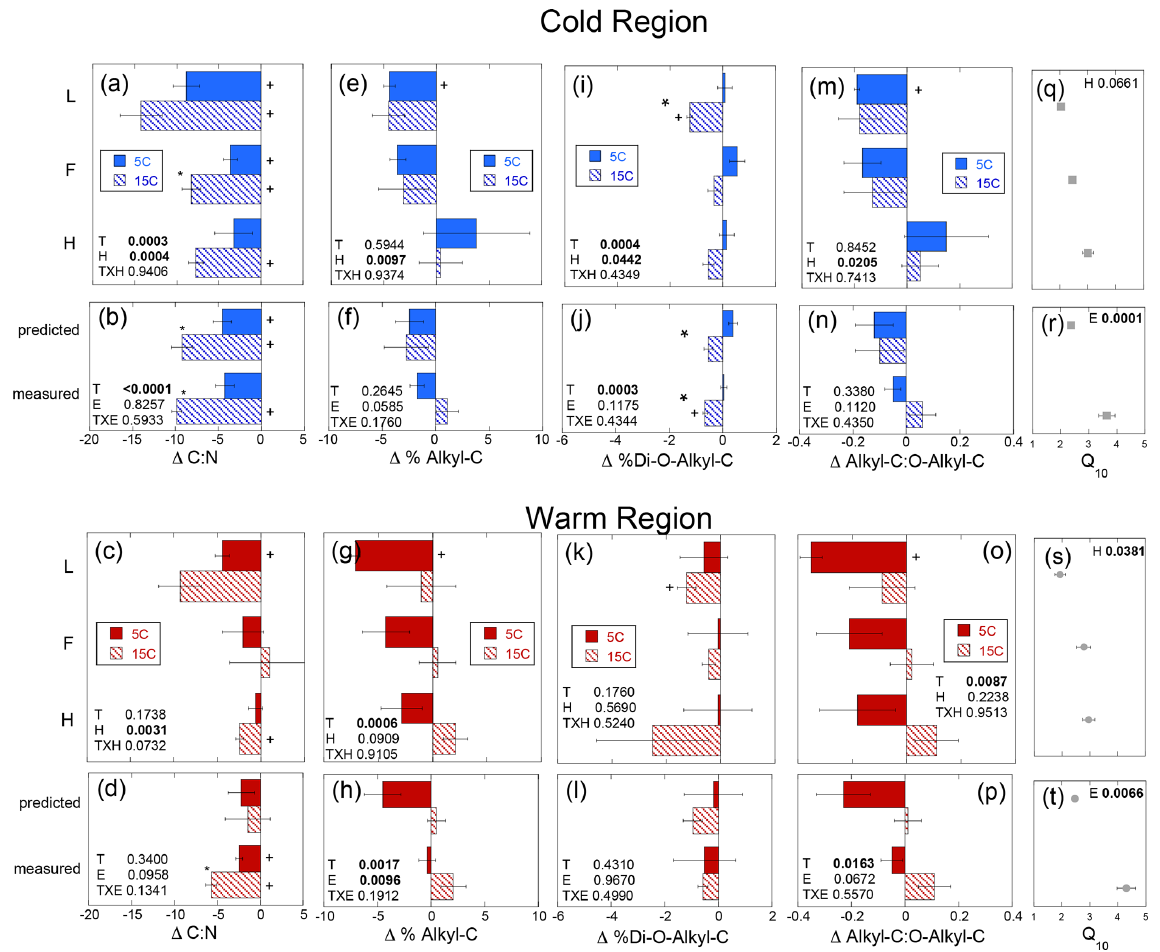
Figure 5. Change in the soil C to N ratio ( (cid:49) C:N), percent of soil carbon as alkyl-C ( (cid:49) % Alkyl-C) and as di-O-alkyl-C ( (cid:49) % Di-O-Alkyl- C), and the ratio of alkyl-C to O-alkyl-C ( (cid:49) Alkyl-C:O-Alkyl-C) given as the difference between the absolute final minus initial values for the soils incubated as individual horizons in isolation from each other (upper panels labeled by horizon: L , F , and H ) and those calculated as whole profile values based upon those isolated horizon results (predicted) and those measured directly from the incubation of whole organic profiles (measured). These results are given for both the cold (a, b, e, f, i, j, m, n) and warm regions (c, d, g, h, k, l, o, p) . The corresponding temperature sensitivities of the total cumulative respiration for the same incubation period ( Q 10 ; cold region, q and r ; warm region, s and t ) taken from Podrebarac et al. (2016) are provided for reference. All values provided are the mean of the three sites ± the standard error with a significant change from 0 denoted by symbol “ + ”. Any significant ( α ≤ 0 . 05) effect of temperature ( T ), horizon ( H ), or experiment ( E ) or interaction term ( T × H or T × E ) is denoted in bold. A significant effect of temperature within the horizon or within the experiment is denoted by an